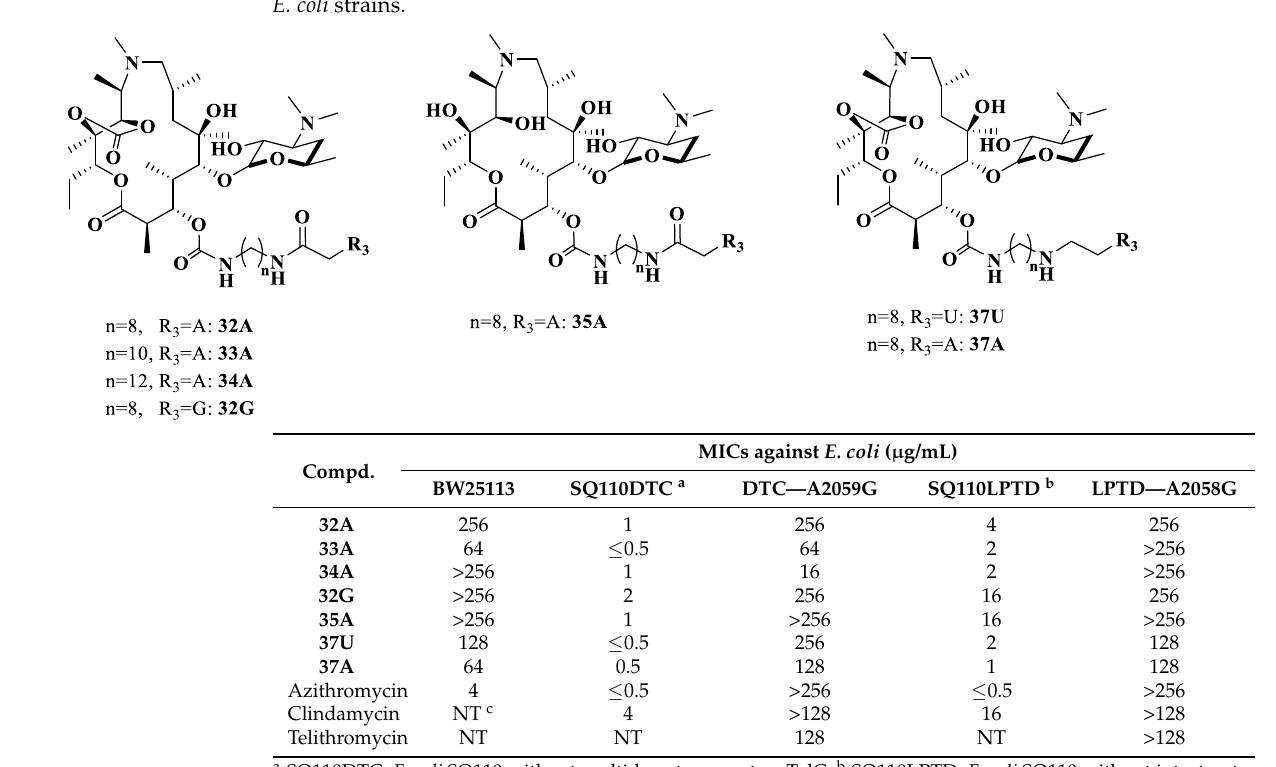
Table 4. In vitro antibacterial activity of 32G, 32A – 35A and 37 against some engineered and mutant E. coli strains.